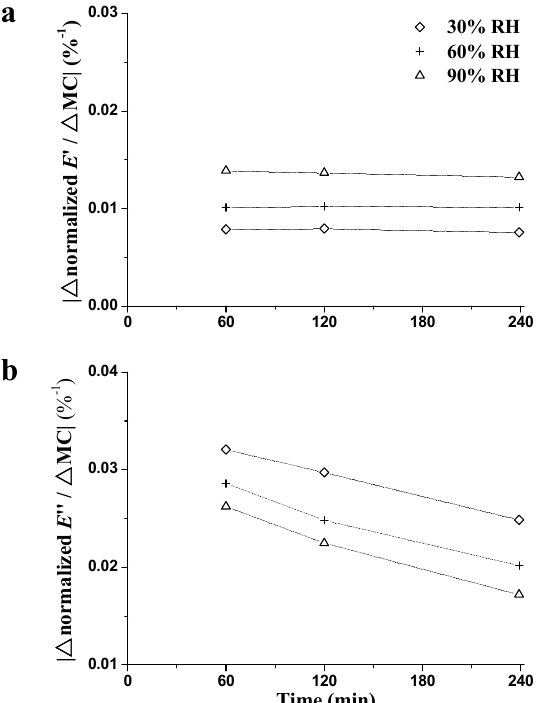
Figure 10. Influence of isohume time on the absolute changes of normalized E ′ ( a ) and normalized E ″ ( b ) per unit change in MC during the RH isohume periods (30%, 60%, and 90% RH).